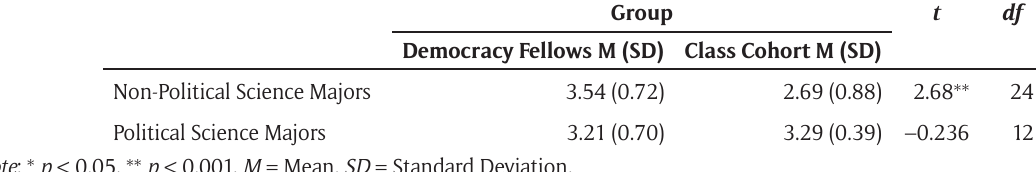
Table 3: Integrative Complexity in Thinking About Citizenship Among Non-Political Science Majors in the Democracy Fellows and in the Class